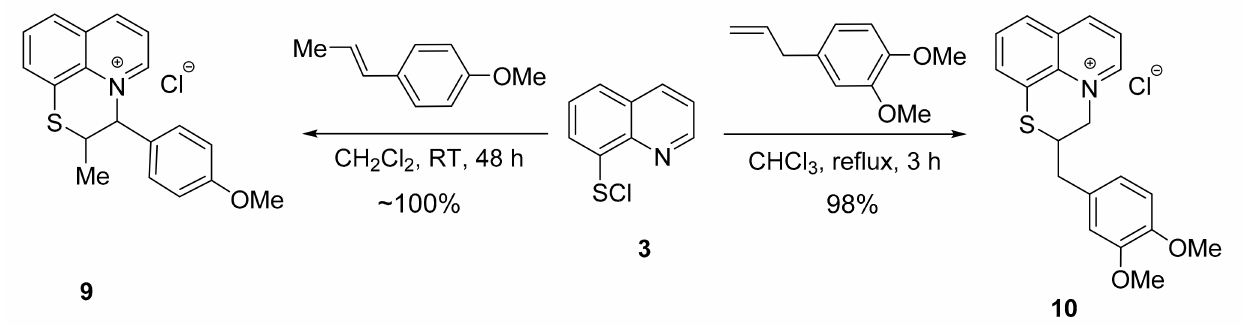
Scheme 5. Synthesis of compounds 9 and 10 by the annulation reactions of sulfenyl chloride 3 with trans -anethole and methyl